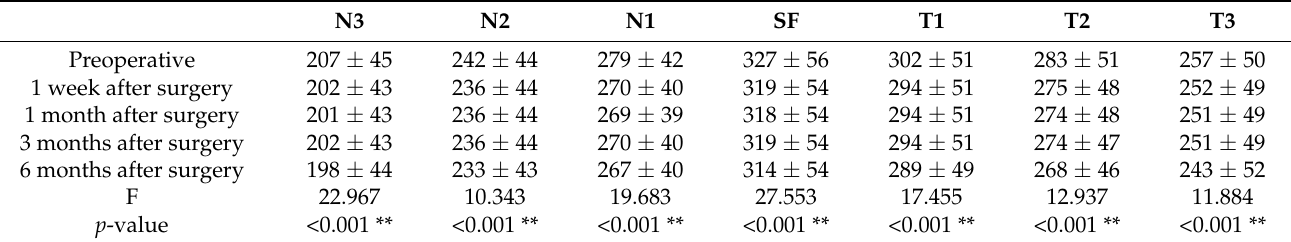
Table 7. Comparisons of CT pre- and postoperatively in the PEI-GSL group.